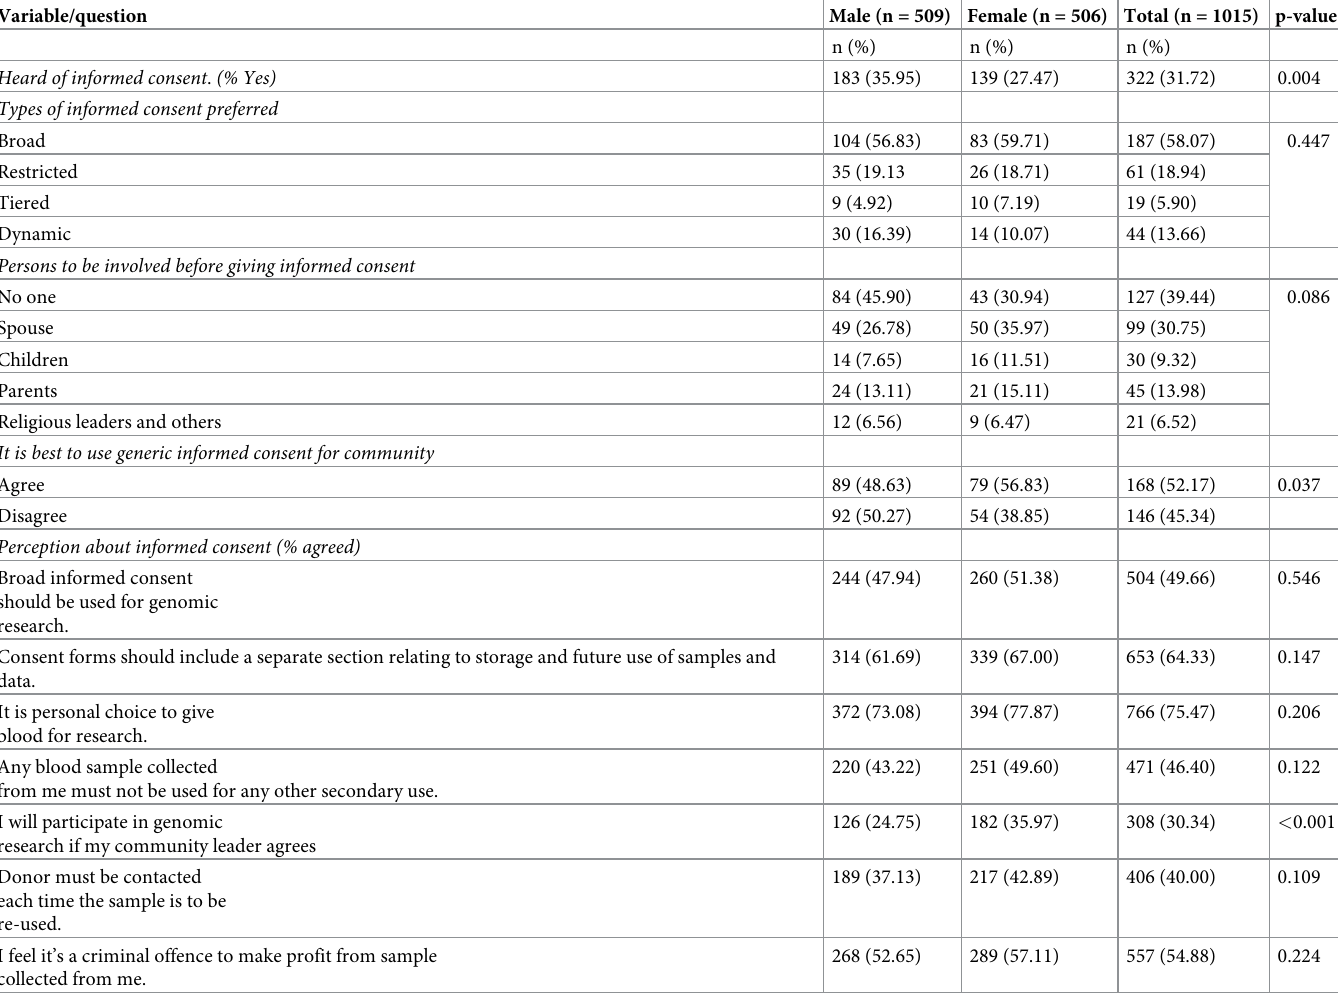
Table 5. Awareness and perception about informed